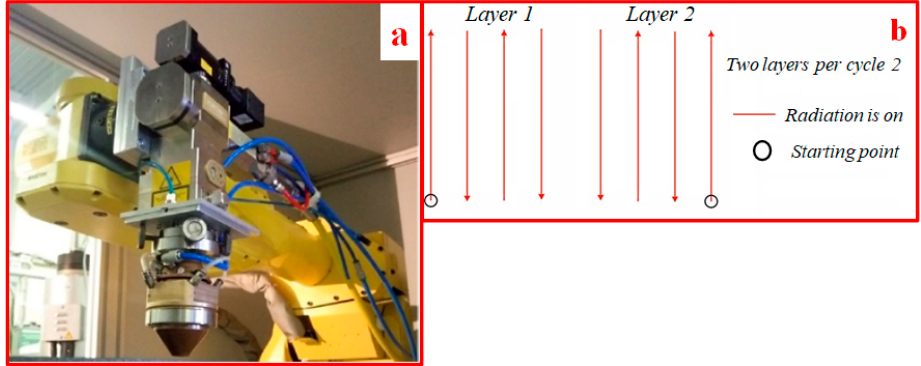
Figure 2. Ytterbium fibre laser LS-3 ( a ); concurrent dual-side deposition strategy ( b ).